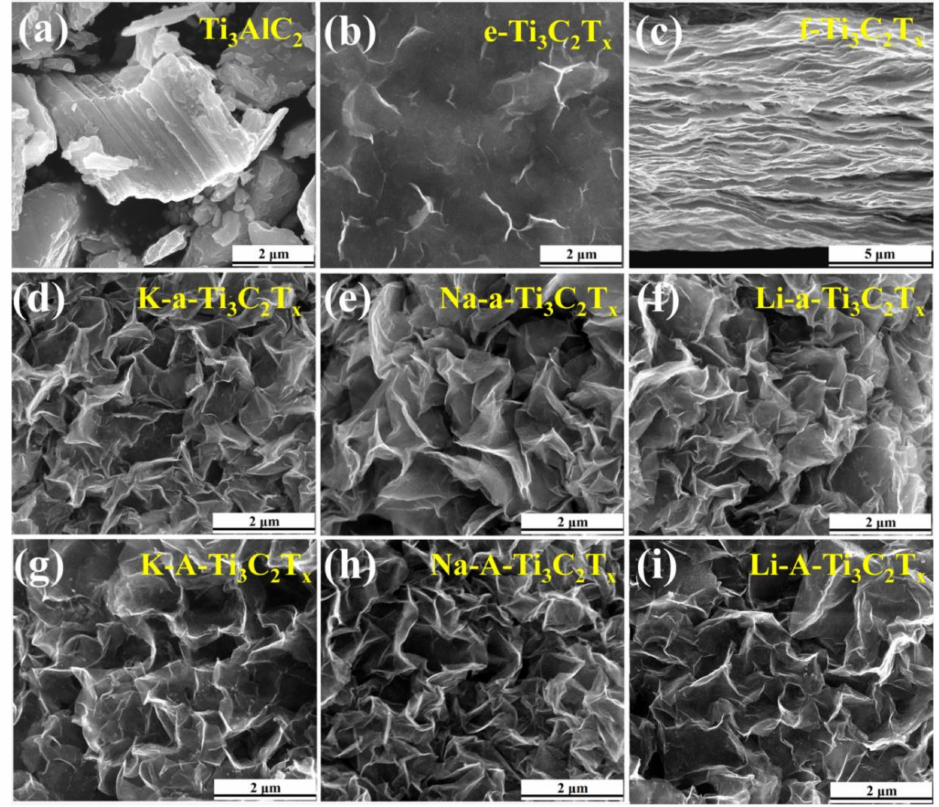
Figure 5. SEM images of: ( a ) Ti 3 AlC 2 , ( b ) e-Ti 3 C 2 T x , ( c ) f-Ti 3 C 2 T x , ( d ) K-a-Ti 3 C 2 T x , ( e ) Na-a-Ti 3 C 2 T x , ( f ) Li-a-Ti 3 C 2 T x , ( g ) K-A-Ti 3 C 2 T x , ( h ) Na-A-Ti 3 C 2 T x , and ( i ) Li-A-Ti 3 C 2 T x . The TEM images of f-Ti 3 C 2 T x , K-a-Ti 3 C 2 T x , and K-A-Ti 3 C 2 T x are shown in Figure